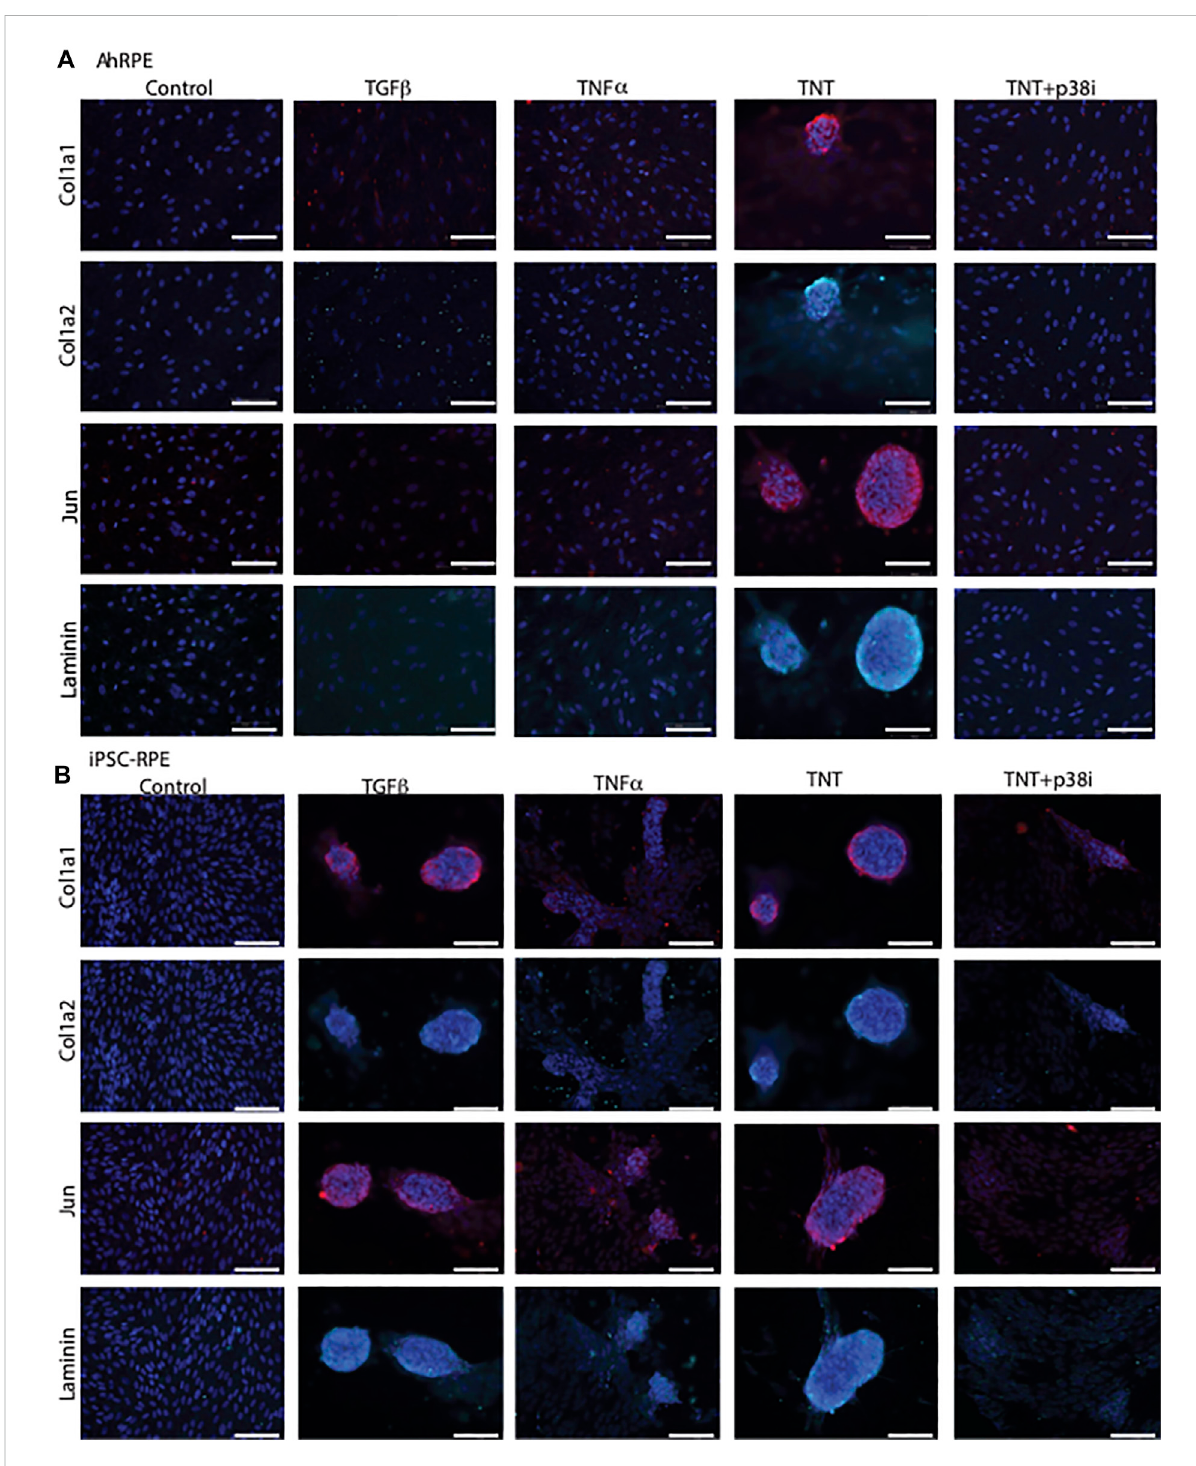
FIGURE 6 iPSC-RPE contractile aggregates are reduced by p38 inhibition. AhRPE and iPSC-RPE were treated with TGF β and TNF α , their combination (TNT), or this combination with a p38 inhibitor SB202190 (TNT + p38i). (A) AhRPE were fi xed and immunostained with the markers of PVR, which included collagen 1a1, 1a2, Jun, and Laminin. (B) IPSC-RPE were fi xed and immunostained with markers of PVR, which included collagen 1a1, 1a2, Jun, and Laminin. Scale bar = 100 μ